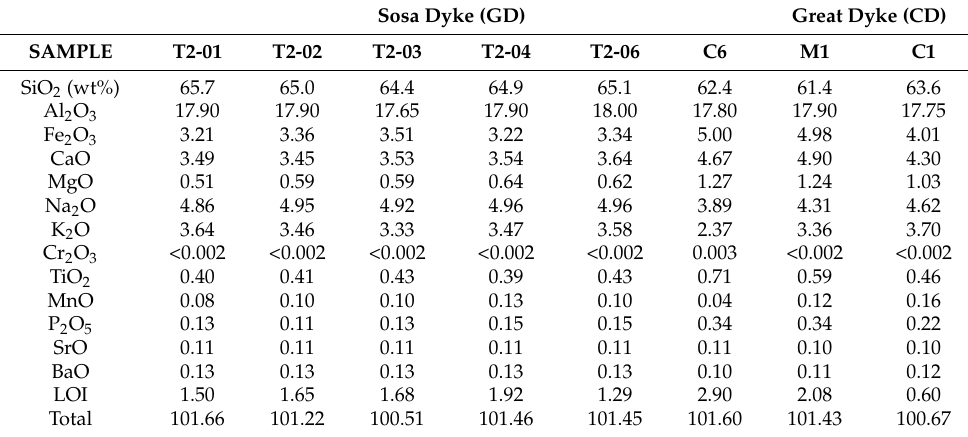
Table A2. Whole-rock major (wt%) ICP analyses of samples from the Sosa dyke traverse T2 (for sample locations see Figures 2 and 7) and the Great Dyke (sample locations Figure